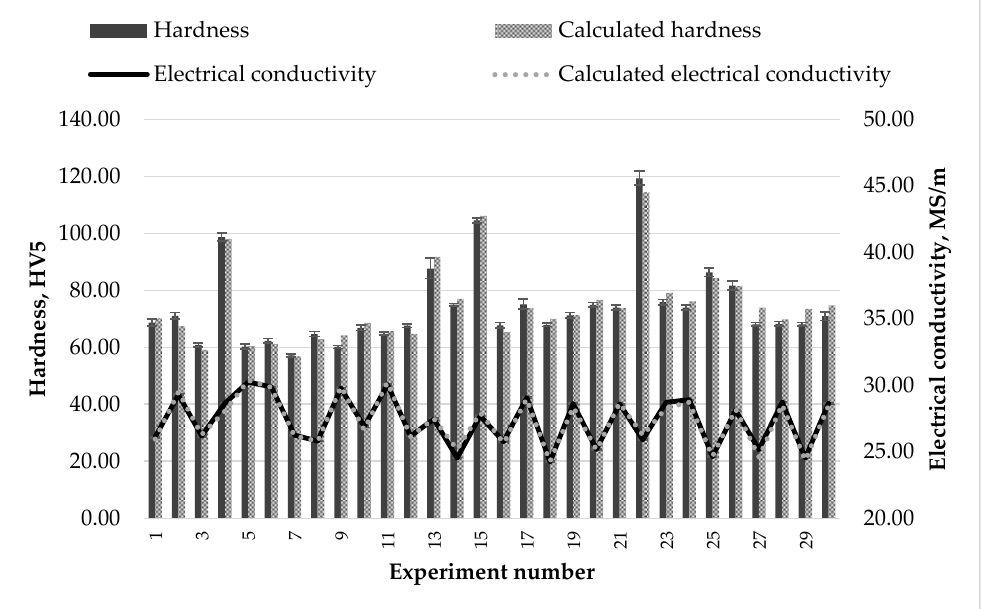
Figure 3. Experimental and calculated data for the hardness and electrical conductivity. The experiment numbers are identical to the numbers in Table 3.